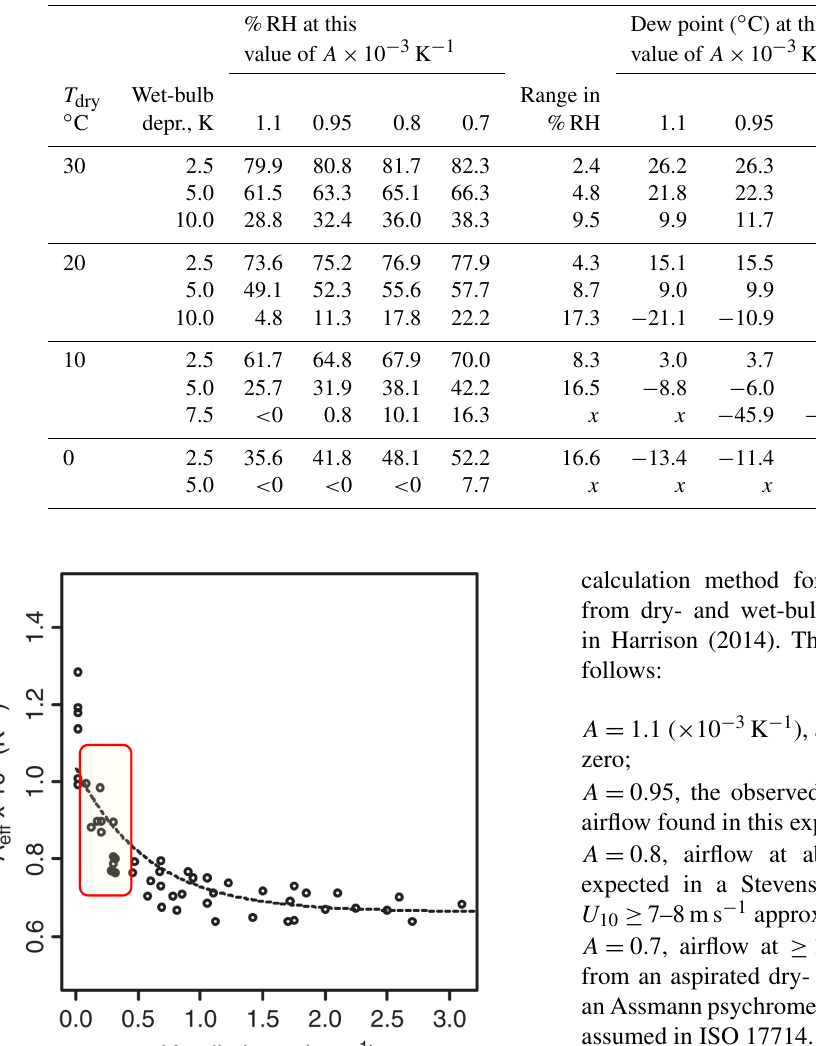
Table 4. Values of %RH and dew point ( ◦ C), and the range in values, calculated for various values of the psychrometric coefficient A ( × 10 − 3 K − 1 ), for a selection of values of dry-bulb temperature ( T dry , ◦ C) and wet-bulb depression (K). Parameter combinations producing %RH below zero, for which the dew point is undefined ( x ), are indicated as < 0.